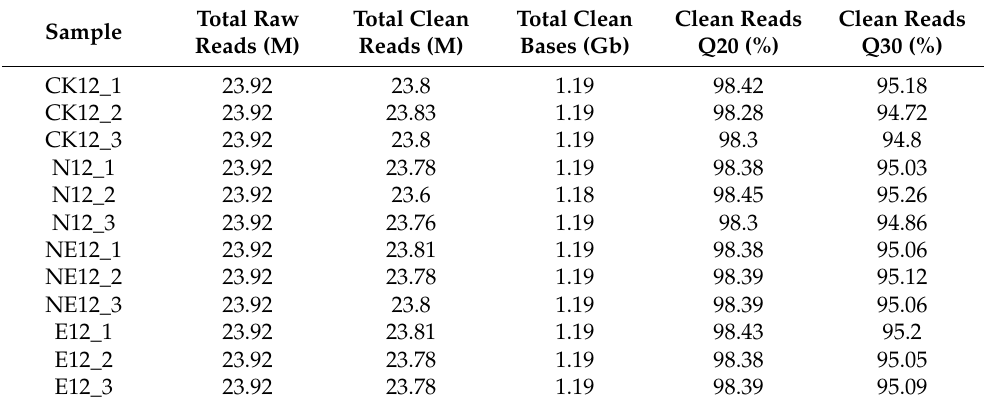
Table 1. RNA-Seq quality statistics.